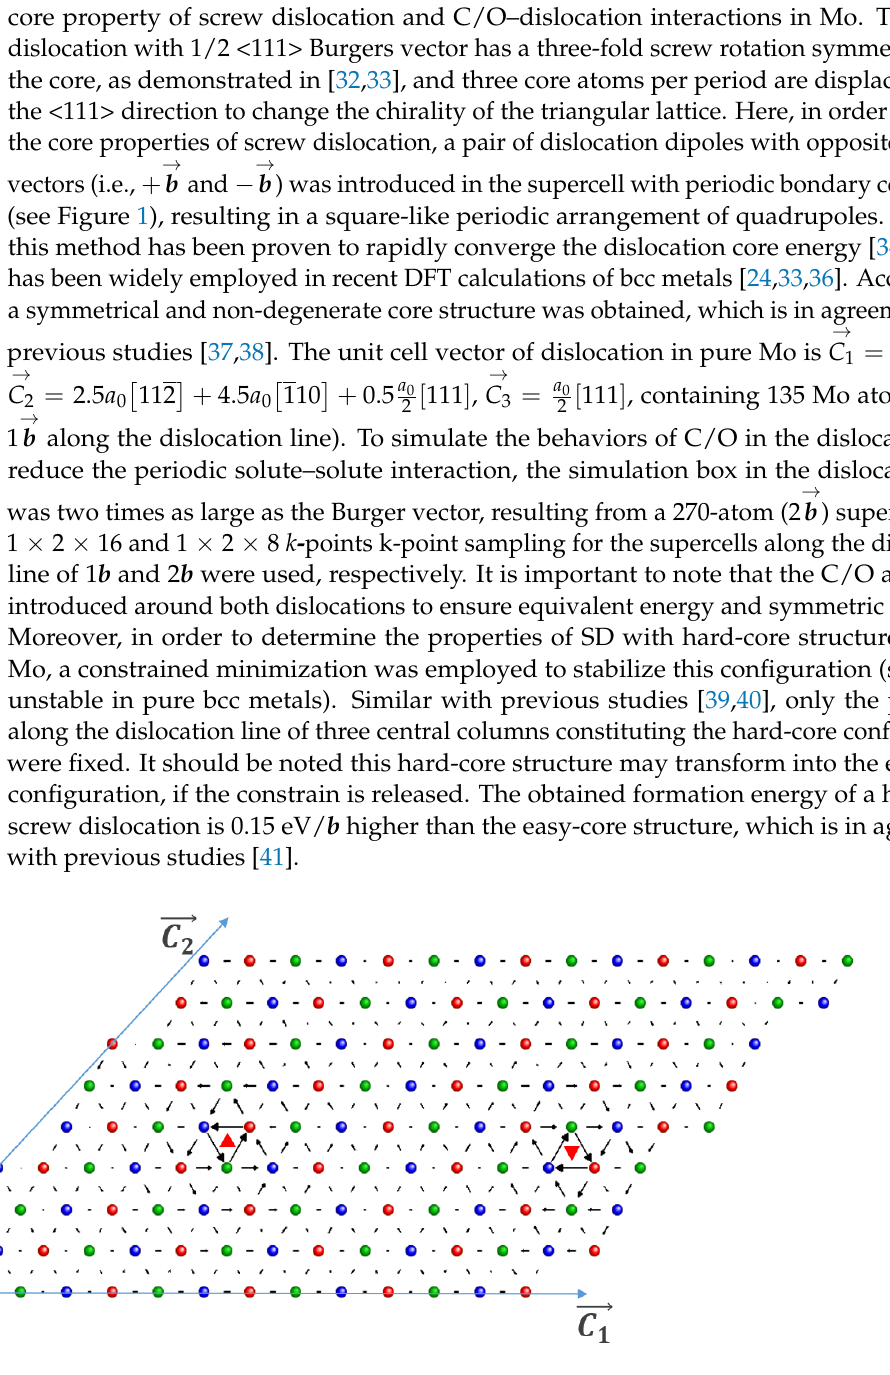
Figure 1. Dislocation dipole within a (111) plane denoted by a differential displacement map. The dislocation center is represented by the red triangle, while the small circles indicate the atomic positions. Three different colors of small circles are used to show that these atoms belong to three different (111) planes before introducing the dislocations.